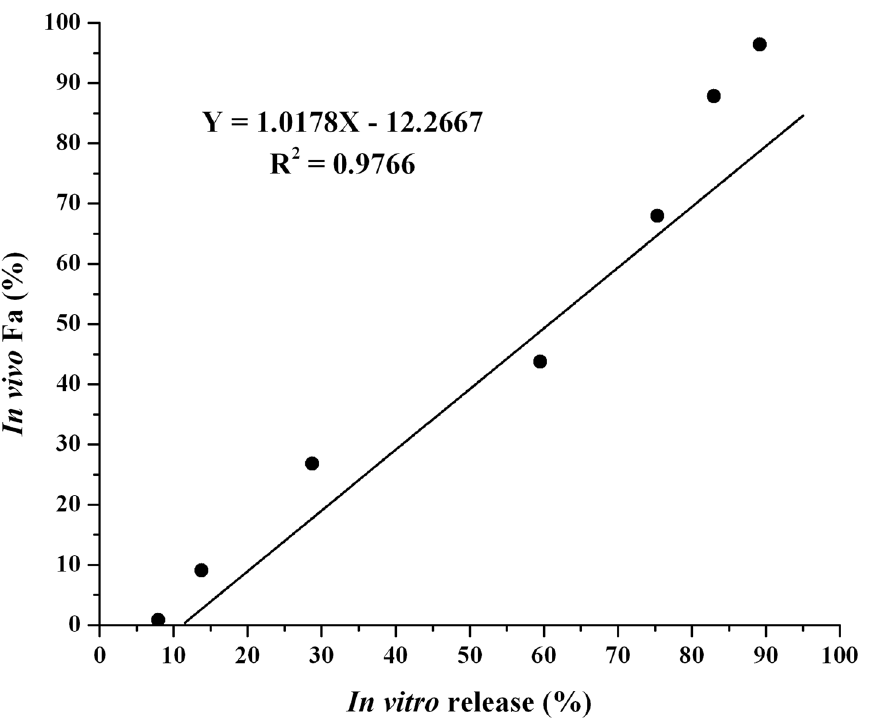
Fig 8. Linear regression plot for the percent released in vitro versus percent absorbed in vivo